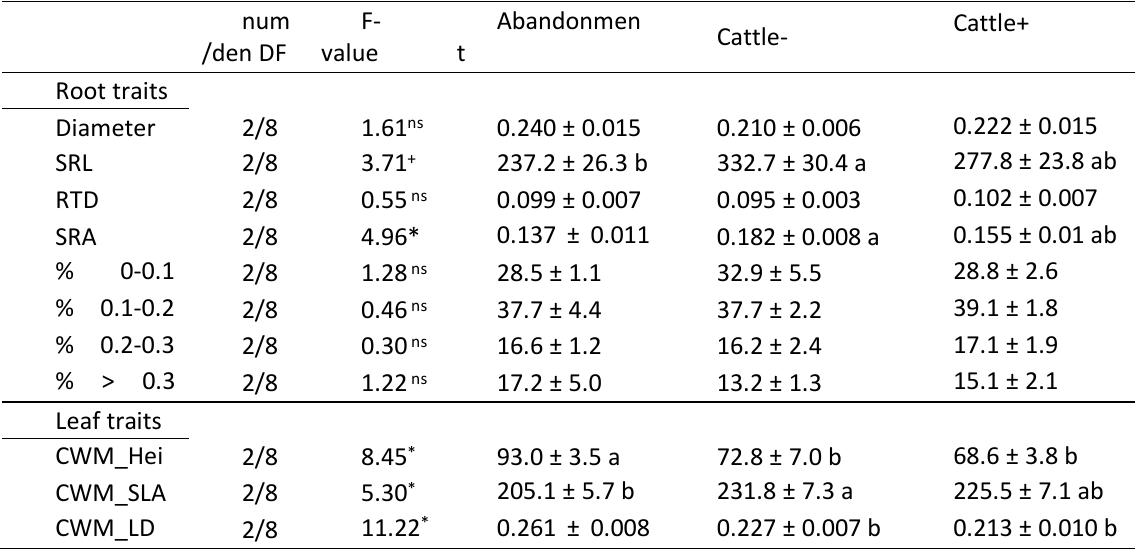
Table 4 . Root traits measured from ingrowth core collected in June 2014 and leaf traits measured from botanical observation in abandonment (May 2014), Ca- and Ca+ (April 2014) treatments. Diameter: root diameter (mm); SRL: specific root length (m g -1 ); RTD: root tissue density (g cm -3 ); SRA: specific root area (m 2 g -1 ); % 0-0.1 mm: percentage of root length in the class diameter 0-0.1 mm; % 0.1-0.2 mm: percentage of rot length in the class diameter 0.1-0.2 mm; % 0.2-0.3 mm: percentage of root length in the class diameter 0.2-0.3 mm; % > 0.3 mm: percentage of root length in the class diameter > 0.3 mm; Community-weighted mean (CWM) Height: plant height (cm); SLA: specific leaf area (cm 2 g -1 ); LDMC: leaf dry matter content (g g -1 ). Means ± SE are shown (n = 4). num/den DF: numerator and denominator of degree of freedom. Superscripts ns, +, *, **, *** correspond to P > 0.1, P ≤ 0.1, P < 0.05, P < 0.01, P < 0.001, respectively. For SRL, SRA, height, SLA and LDMC, different letters correspond to significant differences between treatments. num F- Abandonmen Cattle- /den DF value